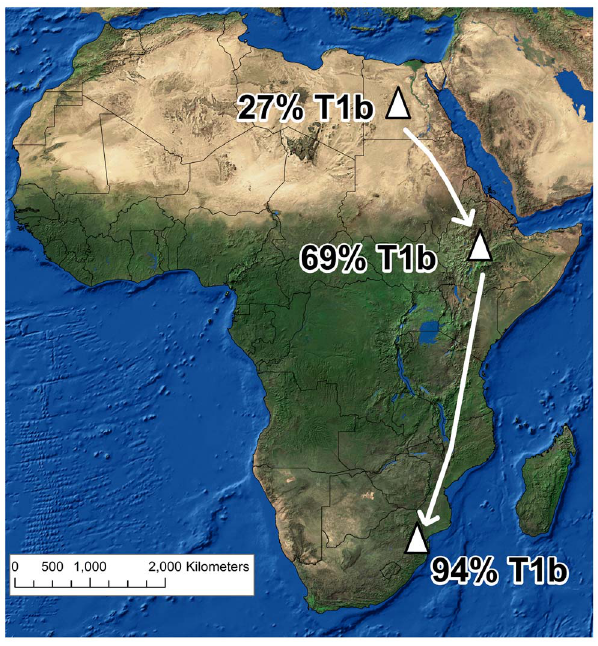
Figure 1. Frequency of subhaplogroup T1b among modern African cattle. Arrows are included only to illustrate the relative order in which populations were established based on radiocarbon dating of archaeological specimens, not as indicators of a specific route of